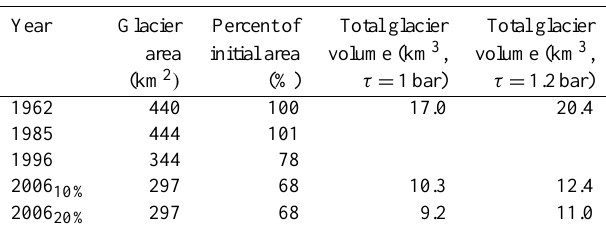
Table 1. Results of glacier mapping and ice volume estimates. For the 2006 volume estimates, a range is presented, based on a 10% and 20% thickness reduction (2006 10 / 20% ) between 1962 and 2006, and basal shear stress values of 1.0 and 1.2bar. Note that the numbers for 1962 are based on aerial photographs (inventory), all other numbers on satellite images (see Sect. 3.1).